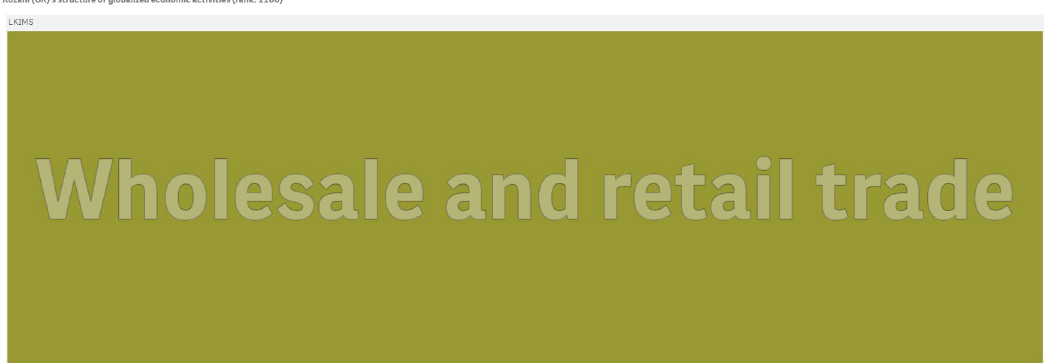
Fig 8. The economic activities of Kozani (GR)’s firms with global presence. Kozani ranks 1100th in the economic complexity index of cities in 2010 (ECI: -0.763). The figure has been generated using Qlik Sense.